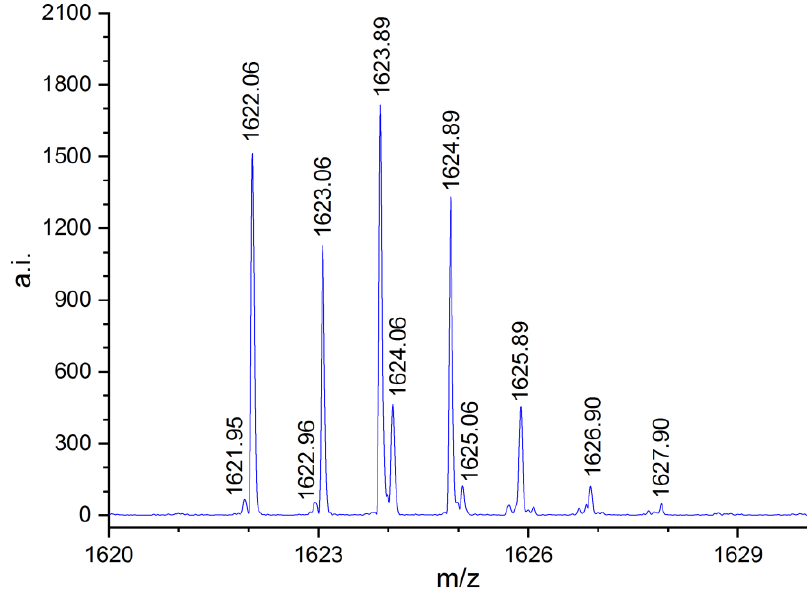
Figure 7. Expansion of the MALDI-TOF MS spectrum showing a region with m/z = 1620–1630. It should be underlined that as the molecular weight increases, the relative intensity of peaks corresponding to PO homooligomers decreases compared to peaks corresponding to CO 2 -containing species. An example to support this statement is shown in Figure 8. The peaks at 1592.12, 1593.13 and 1594.13 (HO-(CH 2 ) 6 -O-(C 3 H 6 O) 25 HNa) have a much lower total intensity than that of the peaks at 1593.95, 1594.96, 1595.96, 1596.96 and 1597.97 (HO-(CH 2 ) 6 -O-(C 3 H 6 O) 22 (CO 2 ) 4 HNa). The signals corresponding to CO 2 -rich chains HO-(CH 2 ) 6 -O-(C 3 H 6 O) 19 (CO 2 ) 8 HNa (m / z = 1595.78, 1596.79, 1597.79) can also be seen in Figure